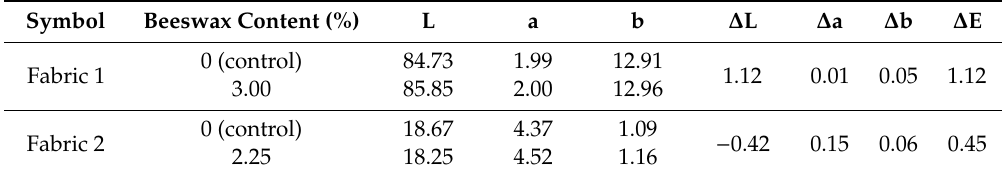
Table 4. Optical parameters of fabrics after modification with